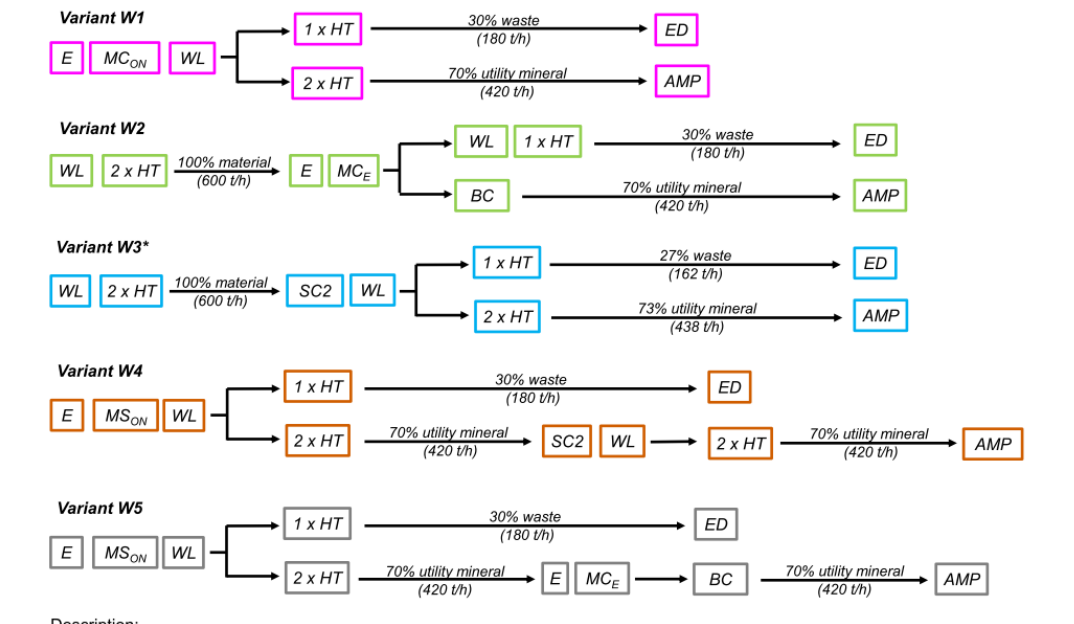
Figure 2. Configuration of the mining equipment in various decision variants.